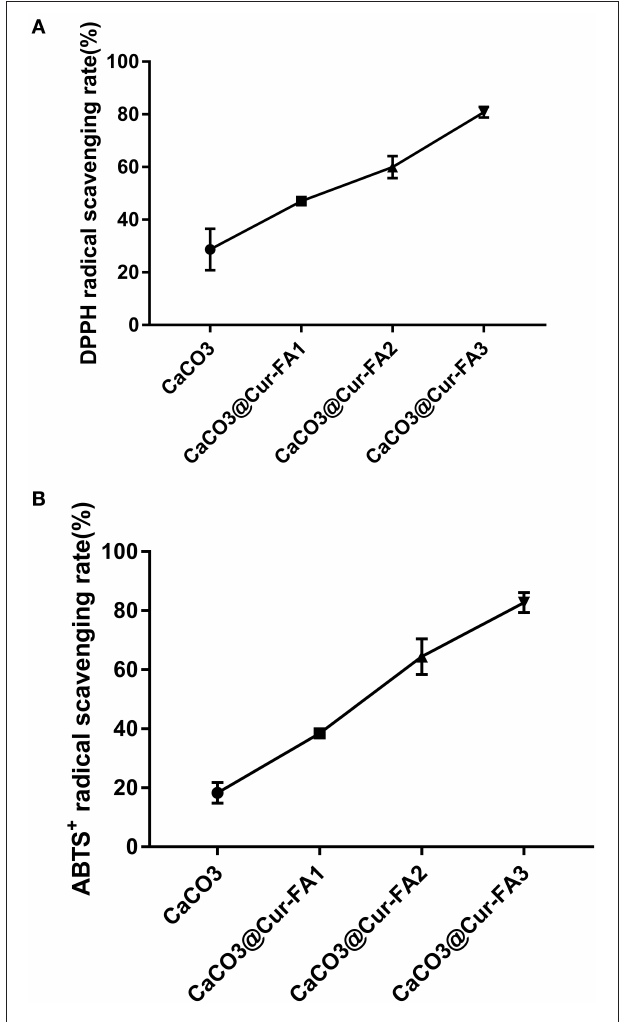
FIGURE 2 | pH sensitivity of CaCO3@Cur-FA. Cur-FA was released from CaCO